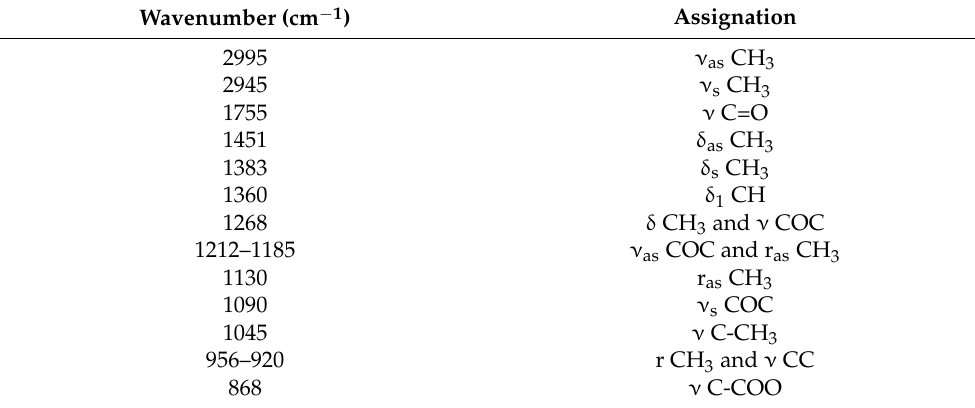
Table 2. FTIR-ATR bands